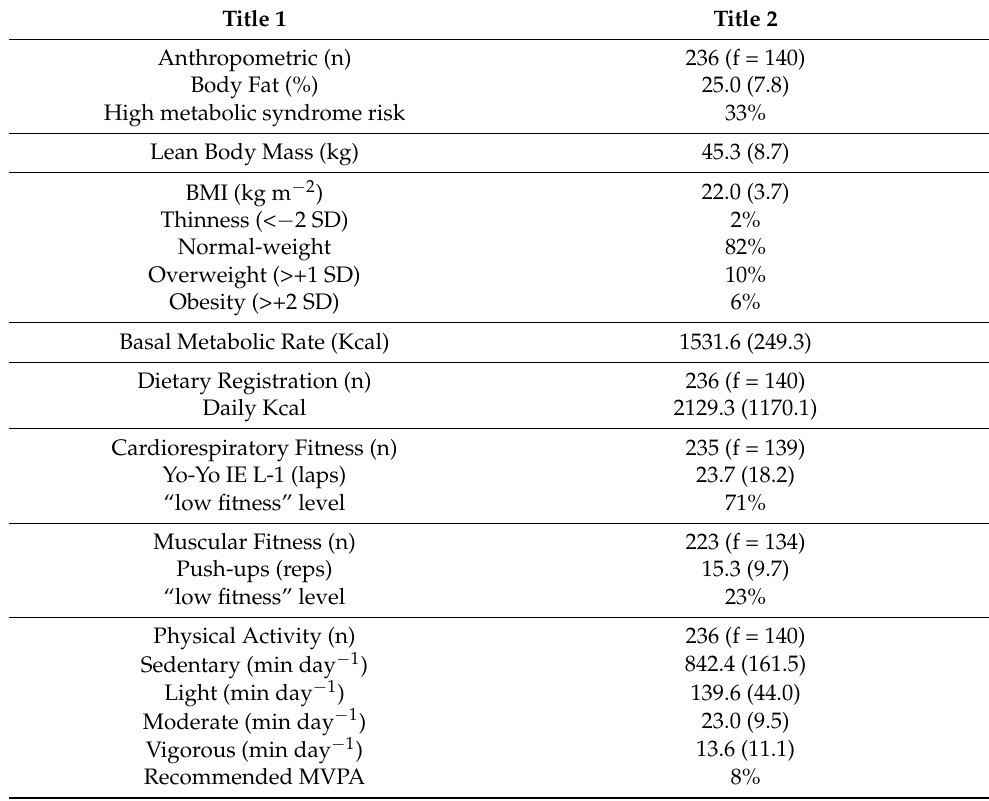
Table 1. Descriptive statistics of study variables (mean ±